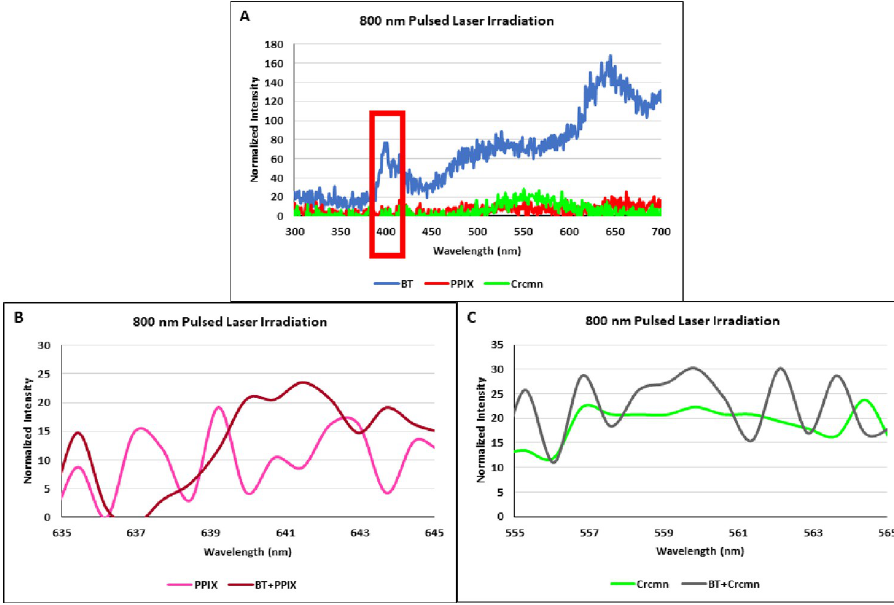
Fig 4. Emission spectra of ( A ) BT (Barium Titanate), Protoporphyrin IX (PPIX), Curcumin (Crcmn); red box highlights the Second Harmonic Generation ( B ) Protoporphyrin IX (PPIX) vs. BT+PPIX (Barium Titanate conjugated with PPIX) and ( C ) Curcumin (Crcmn) vs. BT+Crcmn (Barium Titanate conjugated with Curcumin) after excitation with Near Infrared (800 nm) femtosecond pulsed wave laser